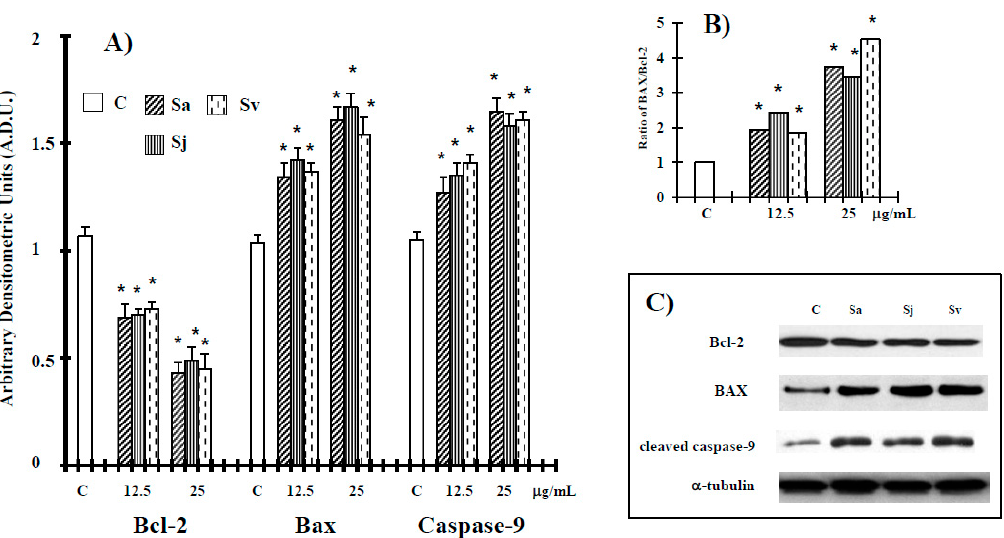
Figure 5. Levels of B-cell lymphoma 2 (Bcl-2), Bcl-2 associated X (Bax) and cleaved caspase-9 proteins in DU-145 cells untreated and treated with different concentrations of the essential oils from Sa, Sj and Sv for 72 h ( A ), and Bax/Bcl2 ratio ( B ). Representative blots of control and essential oils (25 µ g/mL) are reported ( C ). The values are the mean ± standard deviation (SD) of three experiments